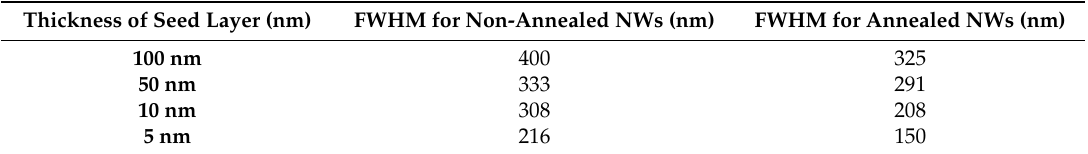
Table 3. Full-width at half-maximum (FWHM) values of the length distribution curves of ZnO NWs for each seed layer